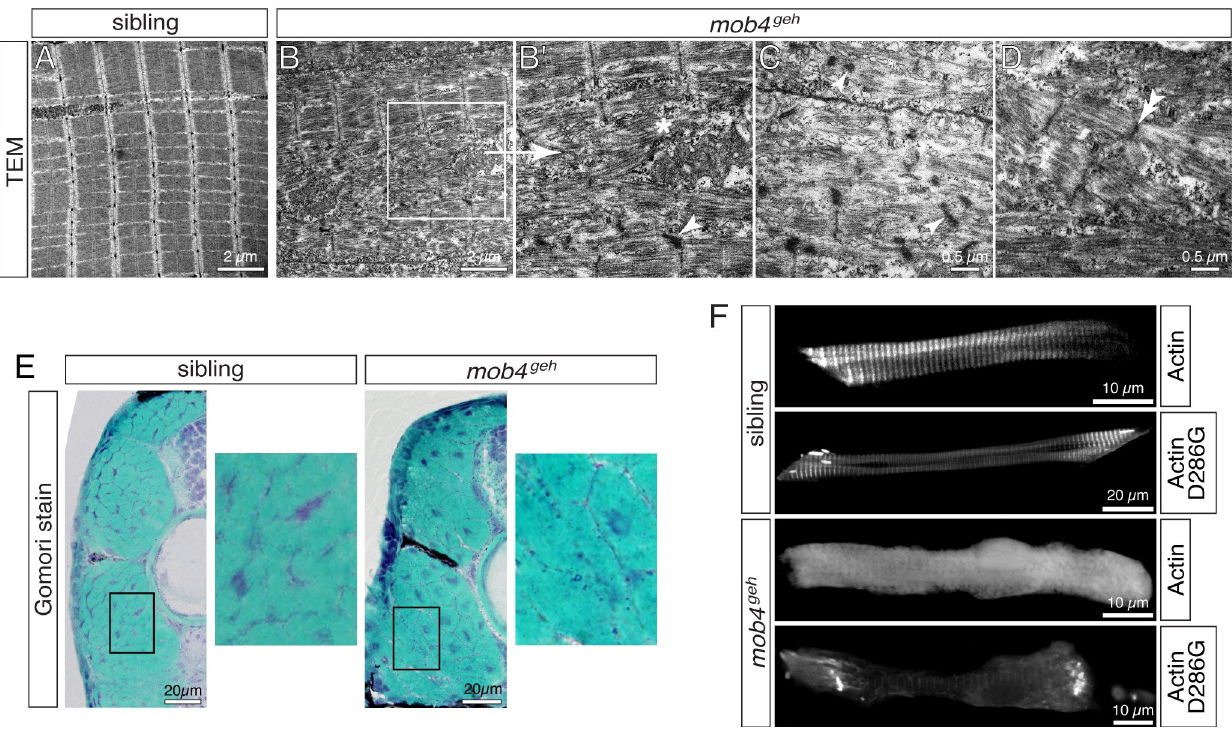
Fig 4. Sarcomere organisation is compromised in mob4 geh mutants. (A) Transmission electron micrograph depicted highly organised and arrayed myofibrils in 3-dpf-old siblings (n = 3). (B) Organised sarcomeres were rarely detected within mob4 geh homozygotes (n = 3). (B’) As shown in the magnification of the boxed area, sarcomeres were frequently disorganised and deposits of isolated filaments (asterisk) in addition to electron-dense structures (arrowhead), often associated with Z-disks, were found instead. (C) Electron-dense aggregates of mob4 geh homozygotes often showed a lattice structure (arrowhead) and (D) fragmented sarcomeres and widened Z-disks (double-arrowhead) were detected as well. (E) At 3 dpf, Gomori trichrome staining revealed subsarcolemmal dark blue structures within mob4 geh homozygotes but not siblings (n = 6 per genotype). Boxed areas are shown in higher magnification. (F) GFP fluorescence of transgenic ACTA1-GFP showed a striated pattern in 3-dpf-old siblings and a uniform pattern in mob4 geh homozygotes. Expression of ACTA1 D286G -GFP led to rod-shaped structures in siblings and exclusively amorphic aggregates within mob4 geh homozygotes (n = 6 per genotype). Scale bar sizes are